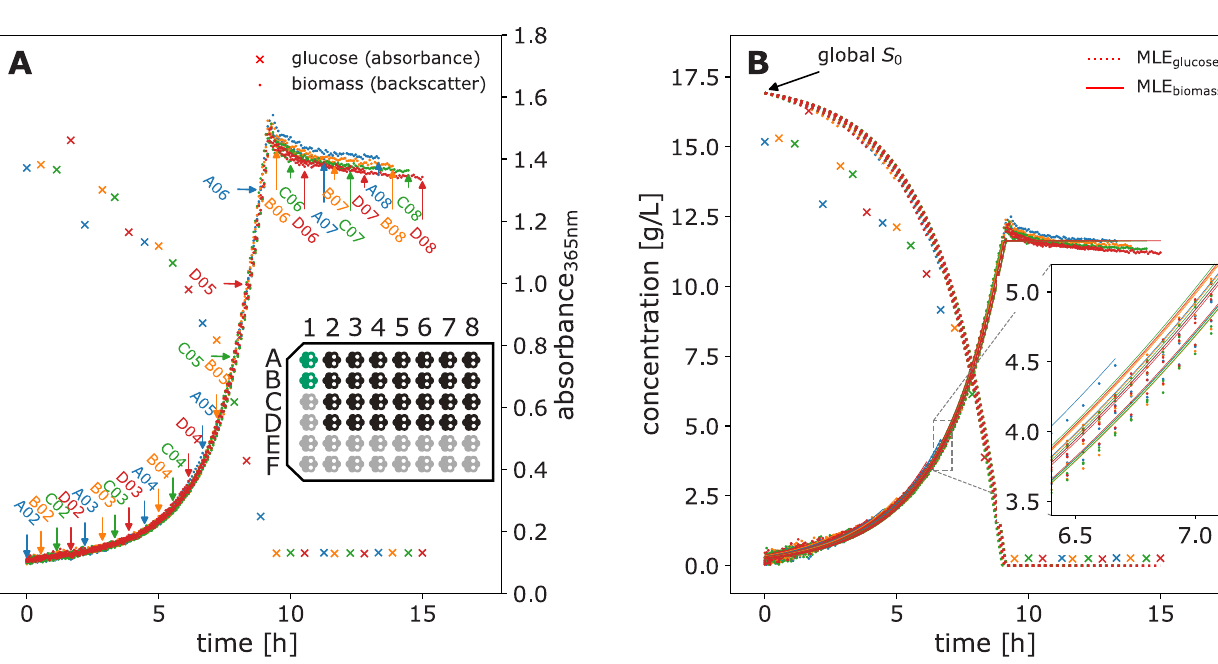
Fig 11. Measurements and maximum likelihood estimate of C . glutamicum growth Monod model. Original measurement responses of online biomass (backscatter) and at-line endpoint glucose assay measurements (absorbance) are shown in ( A ). Glucose measurements were obtained by sacrificing culture wells, hence each backscatter time series terminates at the time of glucose assay observations. The time and well ID of sacrifices are marked by arrows, colored by row in the cultivation MTP. The inset plot shows a typical layout of the cultivation plate (FlowerPlate). The preculture wells are highlighted in green, main cultures in black. In B , the observations and MLE predictions of the ODE process model are shown in SI units. Observations were transformed from original units using the predict_independent method of the respective calibration model. Whereas all curves start at the same global initial substrate concentration S 0 , each well has individual initial biomass concentrations, resulting in the time shifts visible in the zoomed-in inset plot. Biomass observations in the inset plot ( ● ) correspond to the median posterior inferred from each backscatter observation individually.